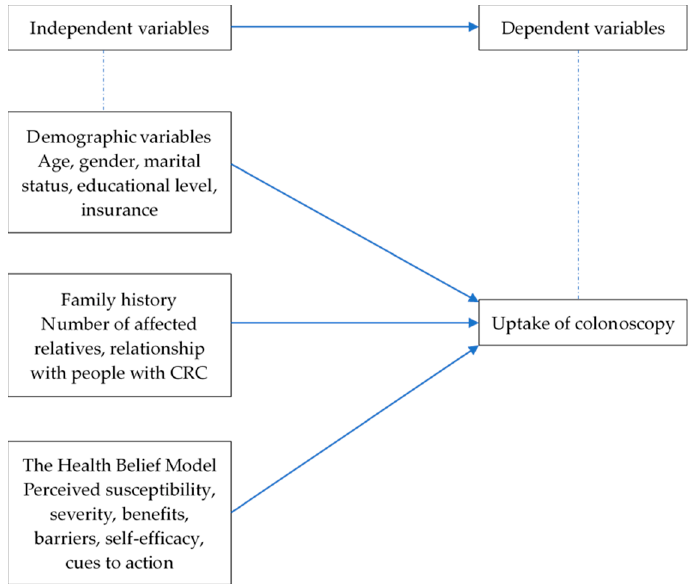
Figure 1. Independent and dependent variables. CRC: colorectal cancer.